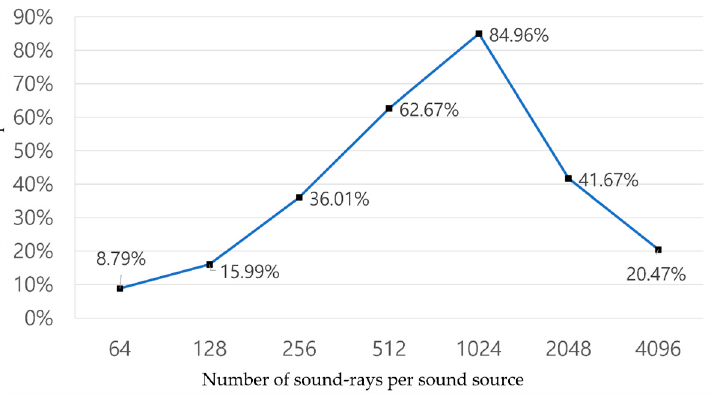
Figure 12. Increase rate of multi-threaded performance compared to single-threaded performance.